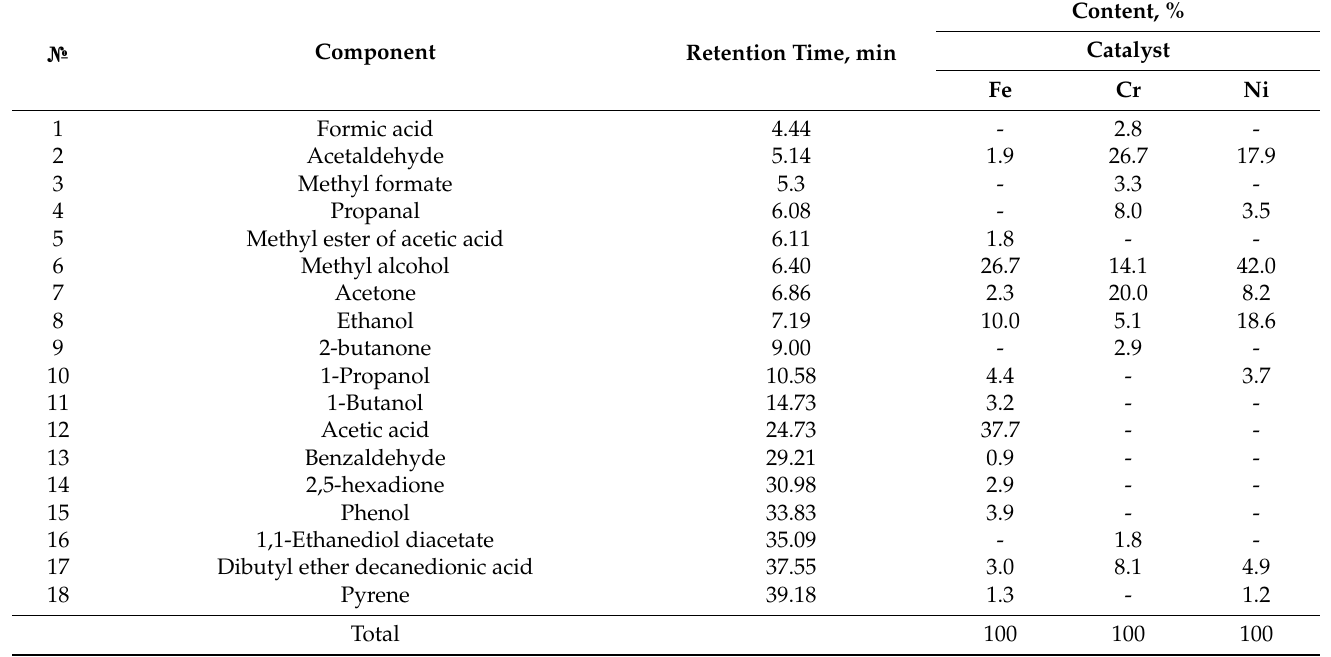
Table 3. The composition of liquid oxidation products (accumulated after Dewar condenser) in the presence of catalysts (estimated from the GC-MS spectra provided in Figure